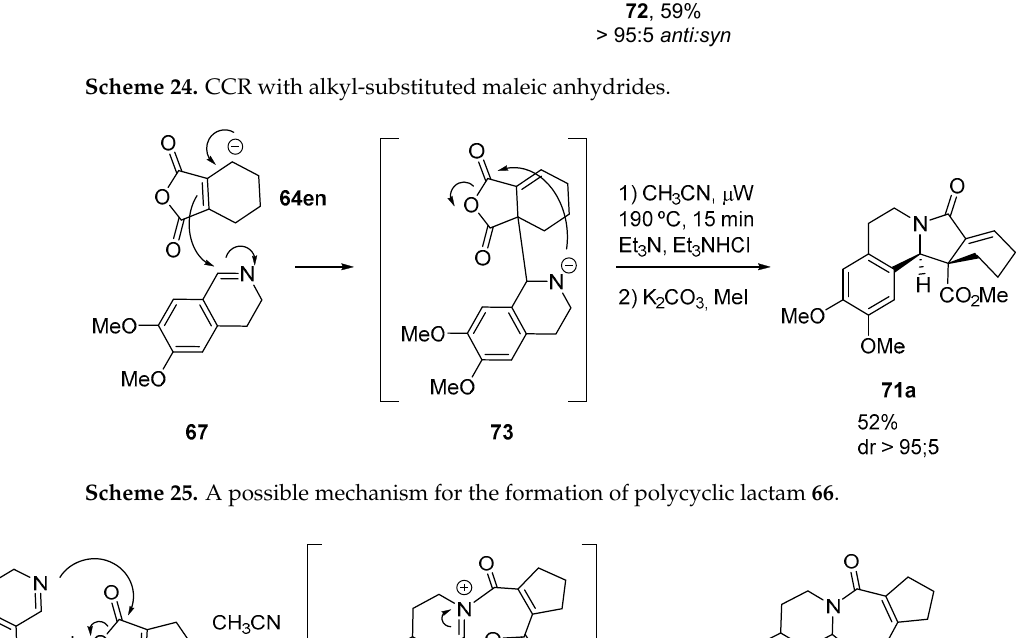
Scheme 27. Iminolysis/aza-Michael sequence leading to tricyclic unsaturated lactam 81 . Interestingly, Royer and co-workers published an identical synthesis of syn lactam 71b simultaneously and independently from that of Shaw. They also reported the reduction of the amide function by treatment with [Et 3 O]BF 4 followed by NaBH 4 to yield antihyperglycemic alkaloid jamtine 82 (Scheme 28) [37]. Scheme 28. Synthesis of (±)-jamtine 81 . Succinic anhydride derivatives in which one of the endocyclic carbons has been replaced with a heteroatom have also been successfully used in CCRs. For instance, Sucu and co-workers employed Leuch(cid:31)s anhydride ( 83 ), a special succinic-type anhydride that can be obtained from amino acids, to obtain a CCR-type product 84 by condensation with imines ( 15 ) in the presence of a base with MeOH as a solvent (Scheme 29) [60].